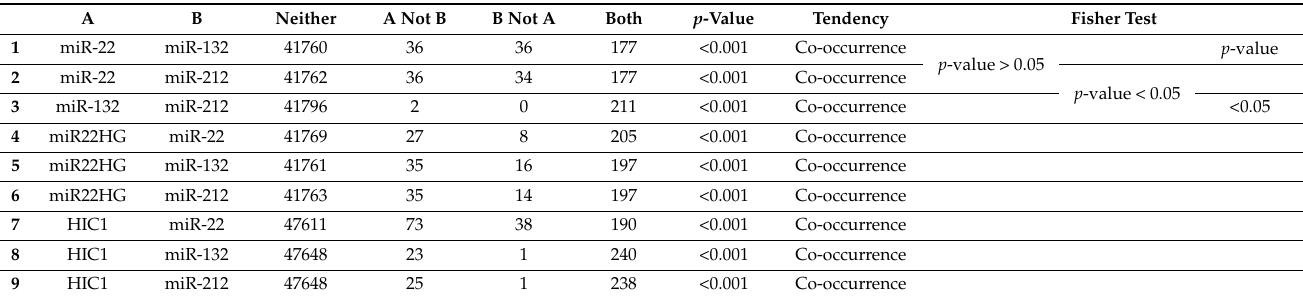
Table 4. Occurrence in genetic alterations of miR-22, miR-212, miR132, HIC1, and miR22HG genes reported in